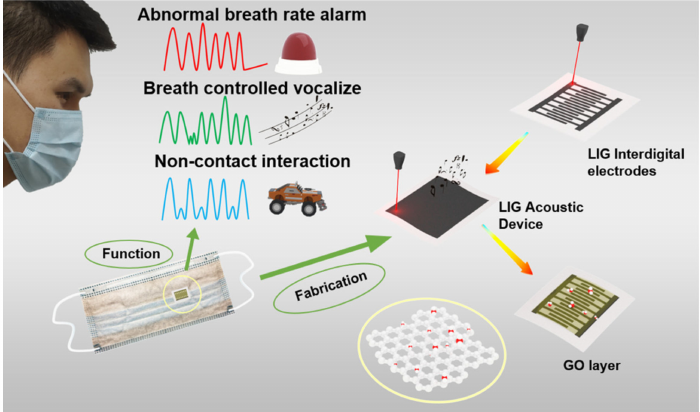
Figure 15. The humidity-based HCI system for health care and non-contact interaction. Reproduced with permission from [29]. Copyright 2022 American Chemical